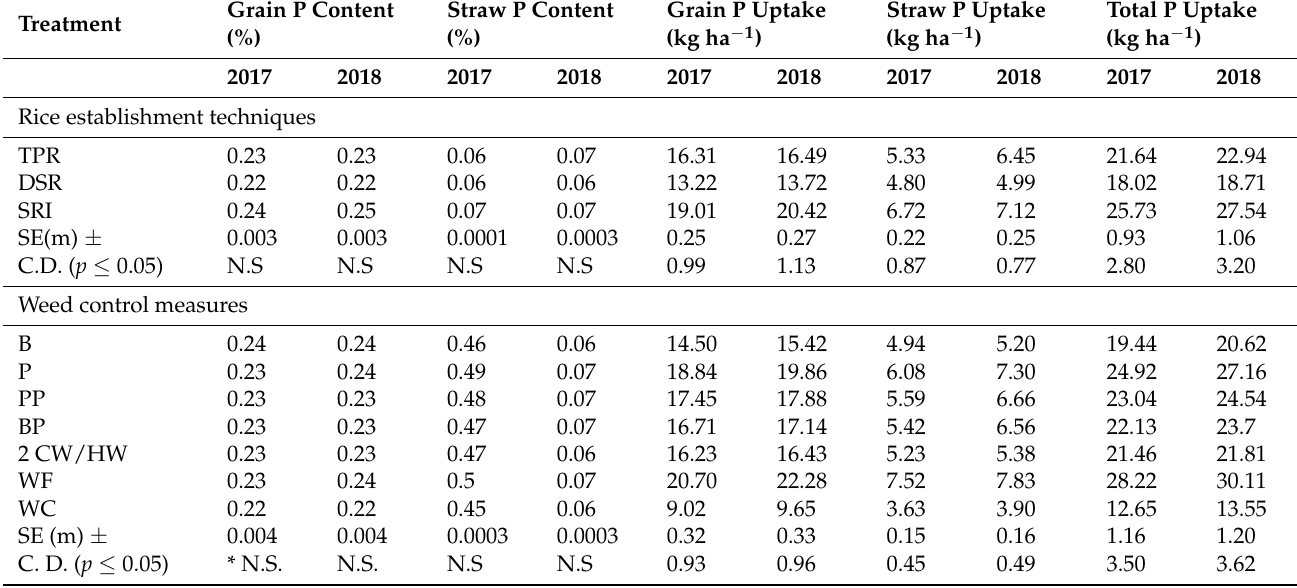
Table 5. Influence of rice establishment techniques and weed control measures on phosphorus content (%) and uptake (kg ha − 1 ) of